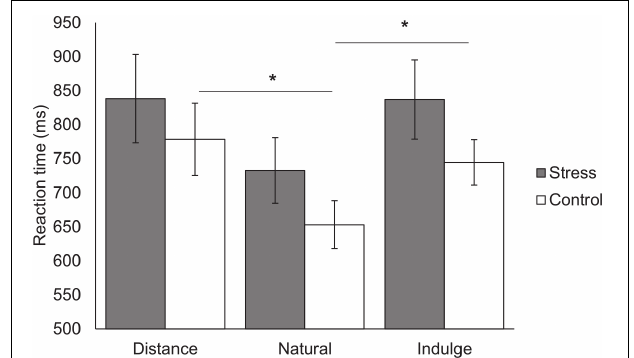
FIGURE 2 | Representation of the reaction time for the different regulation conditions (natural, distance, and indulge) for the stress and control group. The reaction time for natural trials was shorter than for distance [ t ( 13 ) = 4.82, p = 0.001, d = 2.67] and indulge trials [ t ( 13 ) = 3.07, p = 0.027, d = 1.70] in the control group but no statistically significant differences occurred in the stress group. The black star represents statistically significant differences. The main bars represent the mean values and the error bars represent the standard